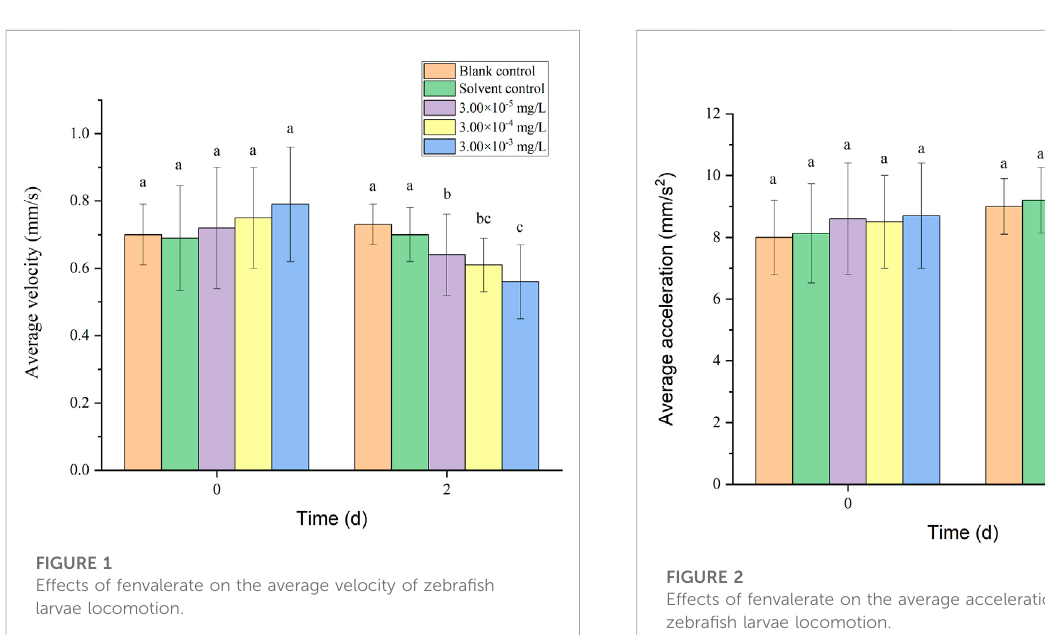
for each day ( p < 0.05, one-way ANOVA). Signi fi cant differences were found at 2d (F = 4.07, dfb = 4, dfw = 10). Data are expressed as the mean ± SD and different alphabets denote signi fi cant differences between the exposure treatments for each day ( p < 0.05, one-way ANOVA). Signi fi cant differences were found at 2d (F = 5.42, dfb = 4, dfw = 10). Data are expressed as the mean ± SD and different alphabets denote signi fi cant differences between the exposure treatments for each day ( p < 0.05, one-way ANOVA). Signi fi cant differences were found at 2d (F = 3.59, dfb = 4, dfw = 10).